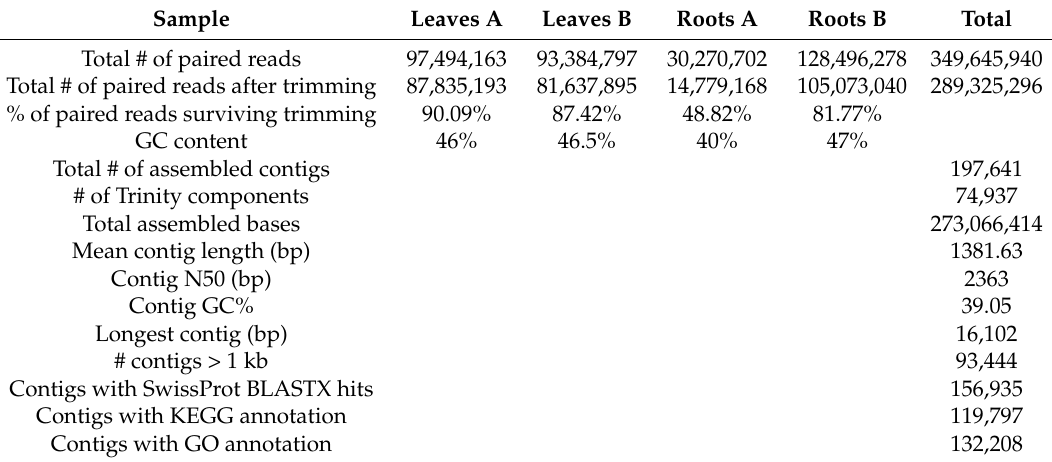
Table 1. Paired-end read quality per